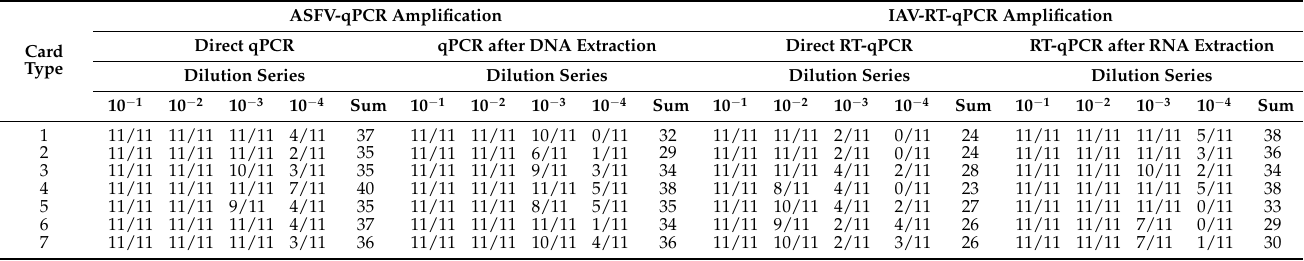
Table 2. Qualitative data analysis of the values of the different DNA/RNA eleven releasing methods based on the seven tested FTA cards (the positive methods based on each card type and dilution series are shown, number of PCR positives/number of releasing methods